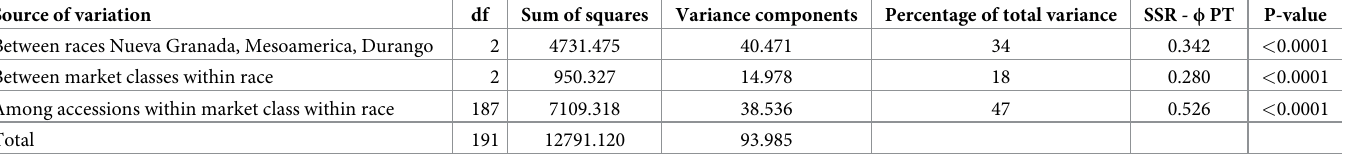
Table 3. Analysis of molecular variance (AMOVA) for the 192 common bean advanced cultivars for two models of genetic structure based on 58 SSR markers.